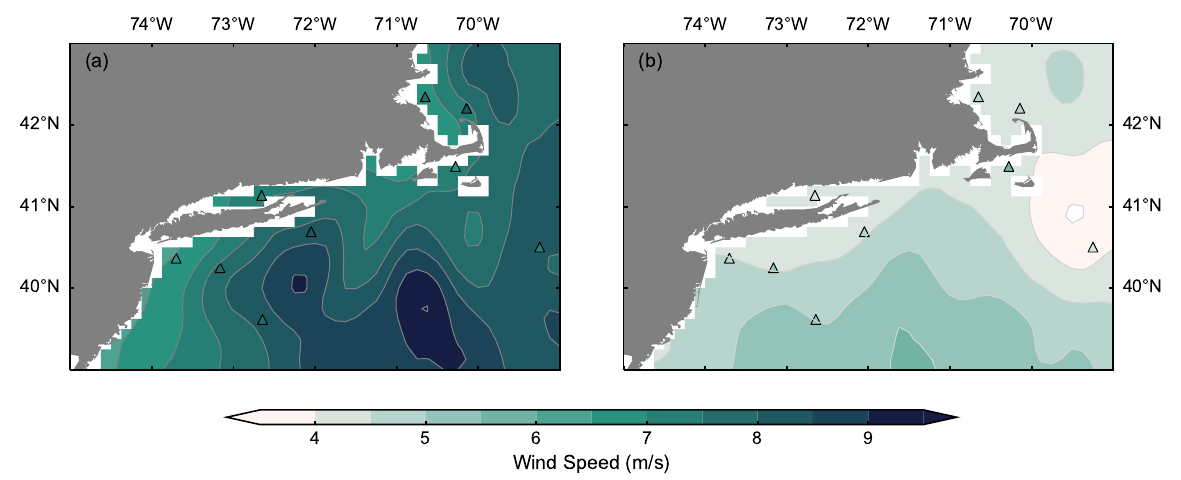
Figure 8. The WS times composites for the 2019 and 2020 winter ( a ) and summer ( b ) seasons were created by interpolating data from the five altimeters used in this study. The colored triangles represent the collocated buoy average WS values to evaluate the altimeter